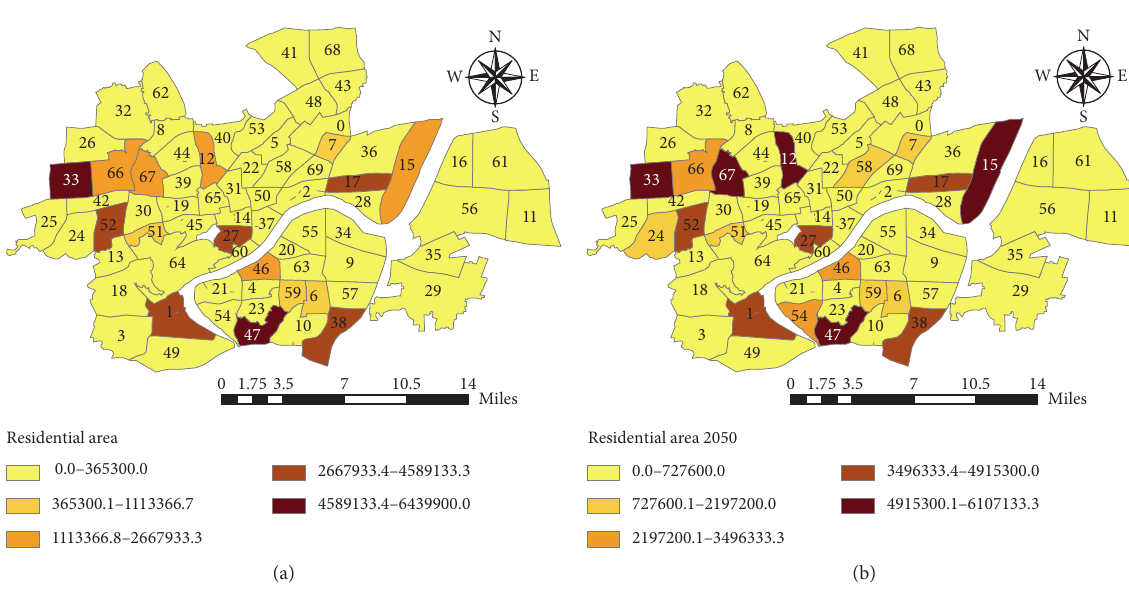
Figure 3: Residential area distributions of Hangzhou, China. (a) Residential area in 2019. (b) Residential area in